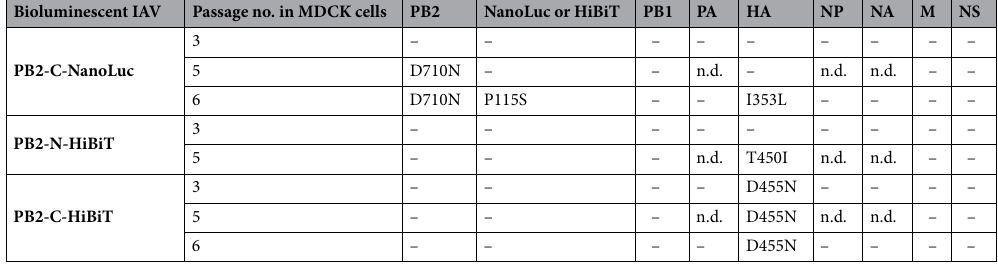
Table 1. Mutations in bioluminescent influenza A viruses sequentially passaged in MDCK cells. − No mutation identified, n.d. not determined.